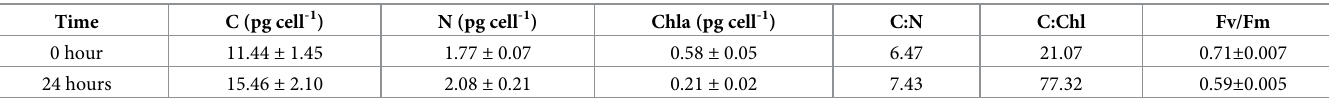
Table 3. Physiological parameters measured at 0 and 24 hours during the low-to-high light acclimation (n = 3 for all samples). Time C (pg cell -1